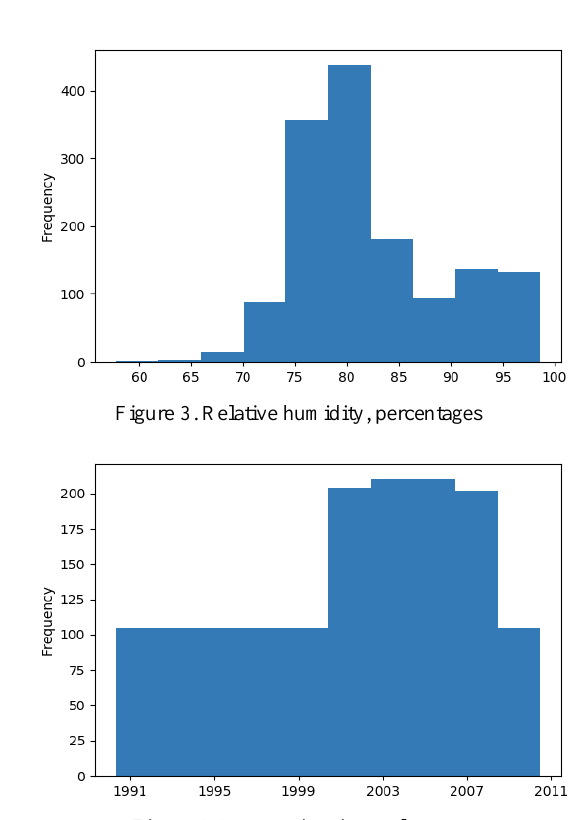
Figure 4. Dataset time interval,